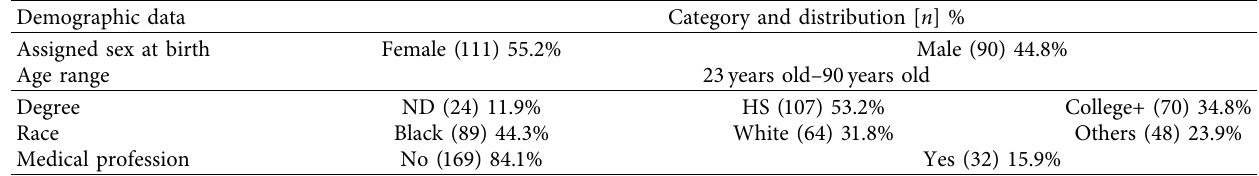
Table 1: Demographic distribution of the patients ( n � 201).